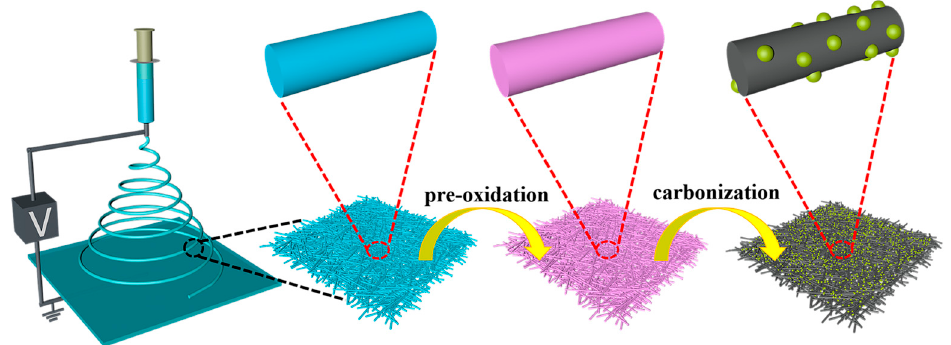
Scheme 1. Schematic diagram of synthesis procedure of Mn 3 O 4 /NiO/CNFs.